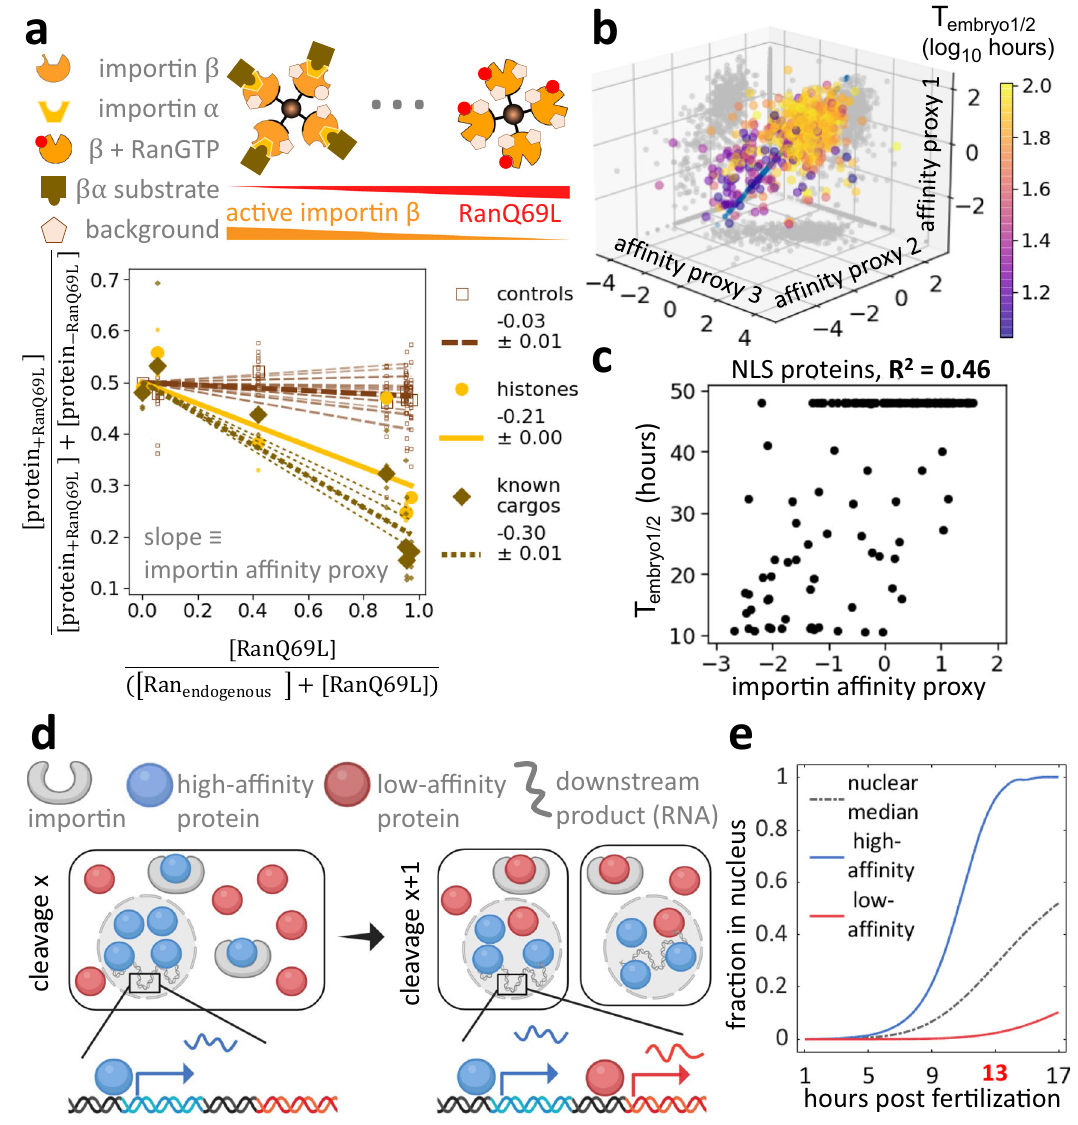
Fig. 4 | The af fi nity of proteins to importin contributes signi fi cantly to their ordering of nuclear entry in early development. a Estimation of proteome-wide af fi nity to importin α / β . We quanti fi ed changes in protein abundance associated with importin beads among conditions with varying amounts of RanQ69L. Abun- dance of known importin α / β substrates 53 , including histones, decreases with increasing RanQ69L concentration. Large dots represent the median protein frac- tion of a protein subgroup at each RanQ69L concentration, while small dots represent measurements for individual proteins. We applied a linear fi t for each proteinwitha fi xed y -interceptandusedtheslopetoproxyforaprotein ’ saf fi nityto importin. b Scatterplotoftriplicateaf fi nityproxymeasurementsfromexperiments outlined in ( a ). We integrated these measurements to one dimension using cross- validated canonical correlation analysis 49 . c Importin af fi nity can explain a sig- ni fi cant fraction of the timing of nuclear entry in early development. The scatter